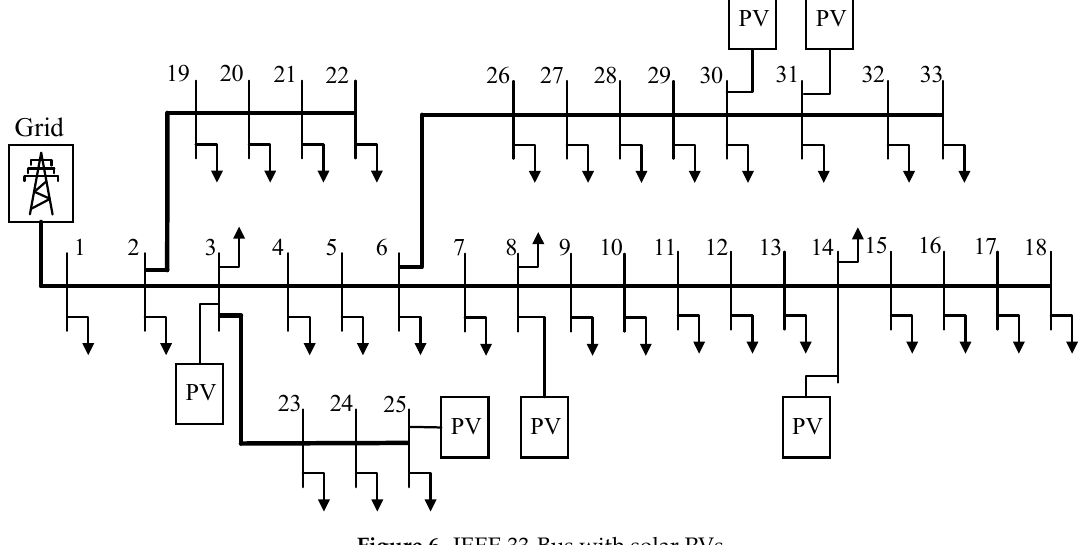
Figure 6. IEEE 33-Bus with solar PVs.